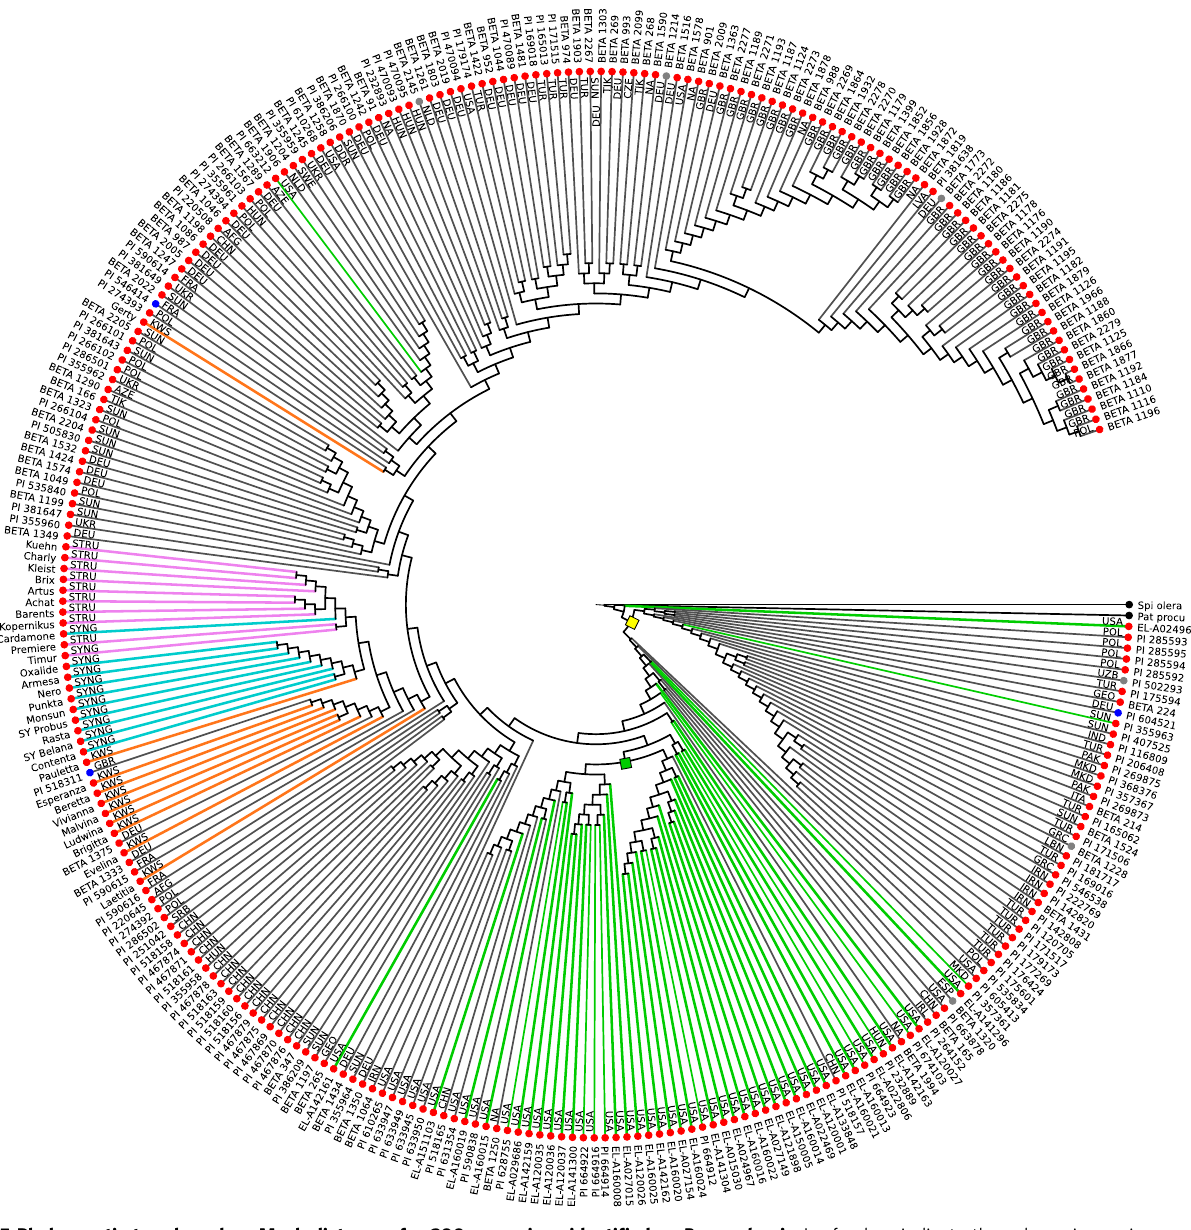
Fig. 5 Phylogenetic tree based on Mash distances for 290 accessions identi fi ed as B. v. vulgaris . Leaf colors indicate the subspecies assignment in databases (red: B. v. vulgaris , blue: B. v. maritima , gray: no assignment, black: outgroup), branch colors indicate breeding programs (green: East Lansing, orange: KWS SAAT SE, cyan: Syngenta, magenta: Strube Research, black: none or unknown). Two nodes were highlighted by a yellow or green square, respectively (see text). Accessions mentioned in the text are highlighted in Supplementary Fig. 5. Source data are provided as a Source Data fi